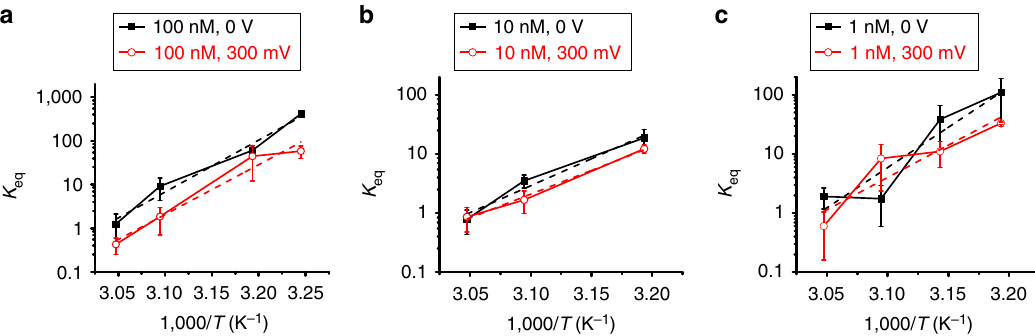
Figure 5 | Reaction thermodynamic parameters are affected by electrostatic force. Van’t Hoff plots depict the effect of bias on the free energy landscape, revealing an order of magnitude lower equilibrium constants and higher enthalpy for the 300mV biased reaction at ( a ) 100nM complementary target, where an increase in D H (cid:2) of 6.5kJmol (cid:2) 1 making hybridization less favourable, ( b ) at 10nM with an enthalpy increase of 38.46kJmol (cid:2) 1 and ( c ) at 1nM with an enthalpy increase of 74.78kJmol (cid:2) 1 . Error bars are calculated from five different 60-s intervals at each temperature.